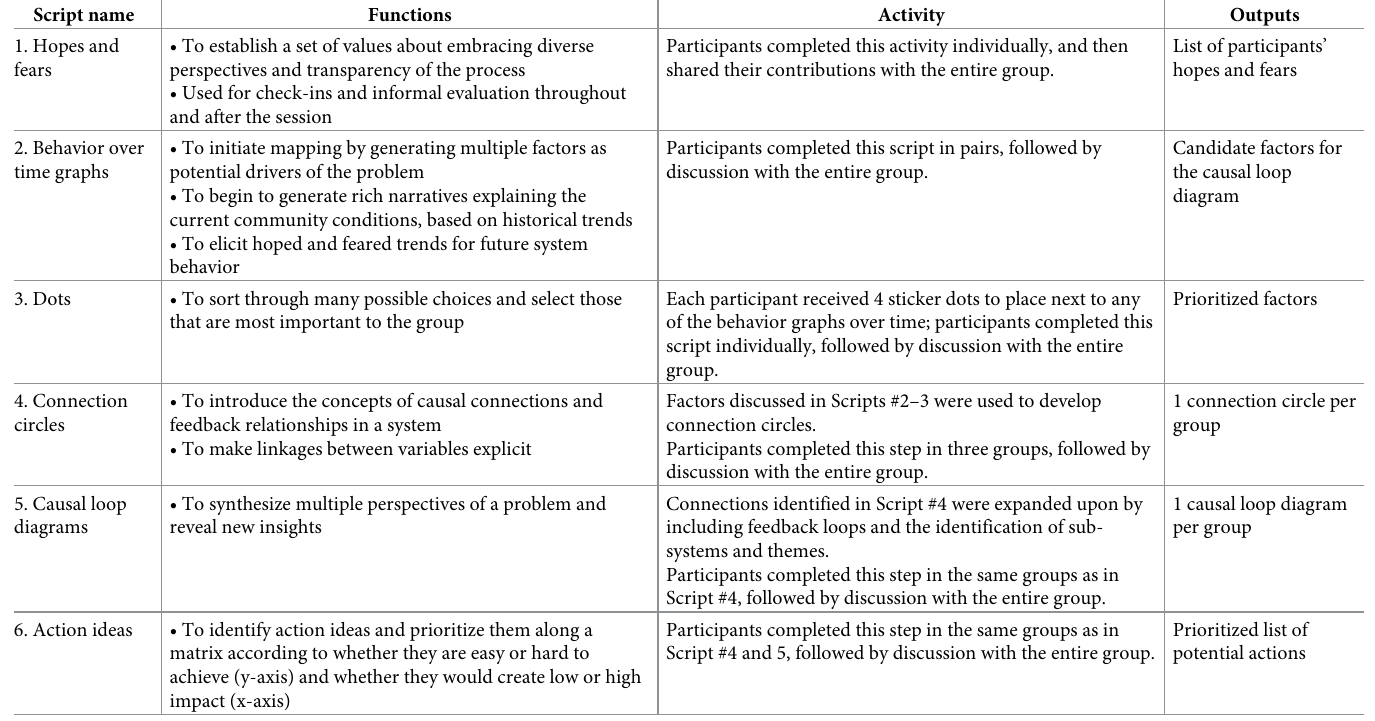
Table 1. Description of the functions, activity, and outputs of each script employed in the group model building